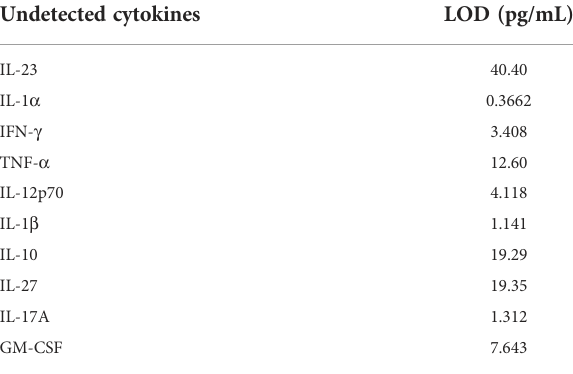
TABLE 1 Limit of detection ( LOD) of undetected cytokines.